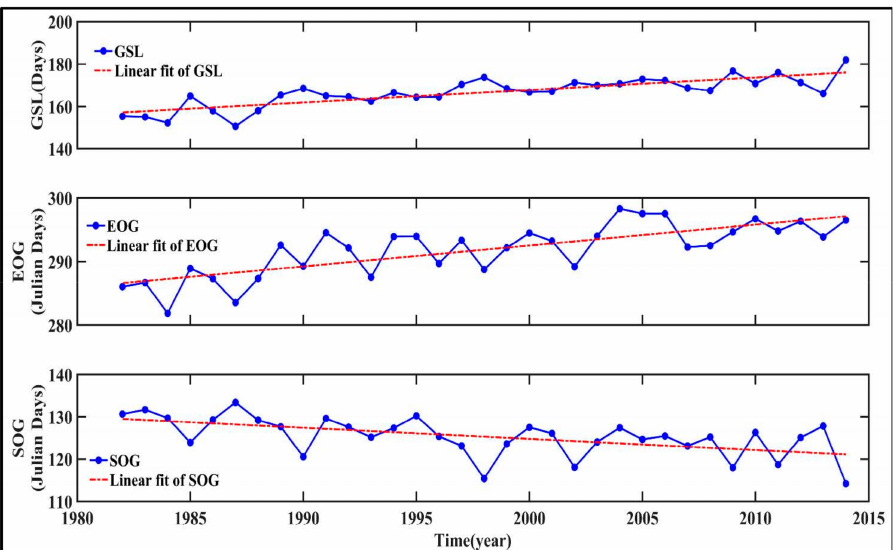
Figure 7. Variation in phenological parameters in the GKM from 1982 to 2014 (SOG means starting day of growing season, EOG means ending day of growing season, and GSL means growing season length).